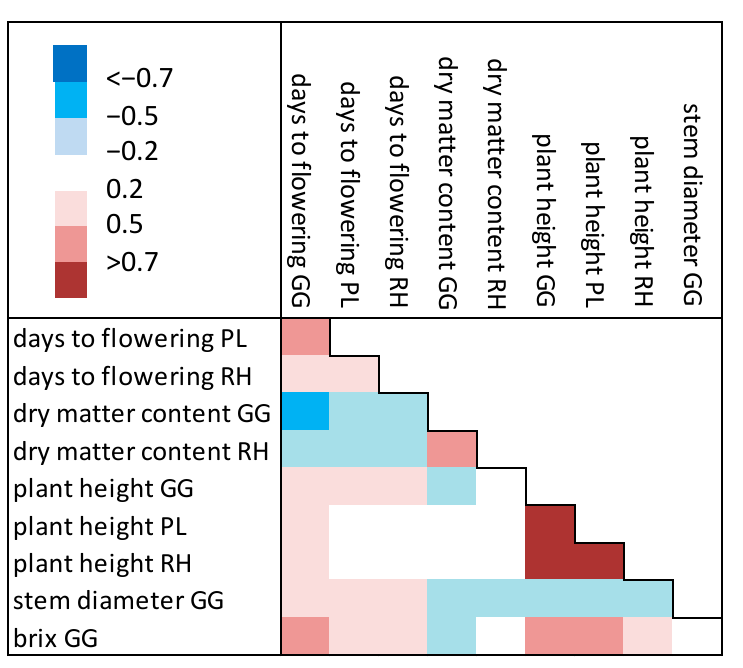
Figure 2. Heat-map showing Pearson’s correlation (r) among different agronomical traits. All highlighted correlations are significant at 0.001 level. RH, Rauischholzhausen; GG, Gross-Gerau.